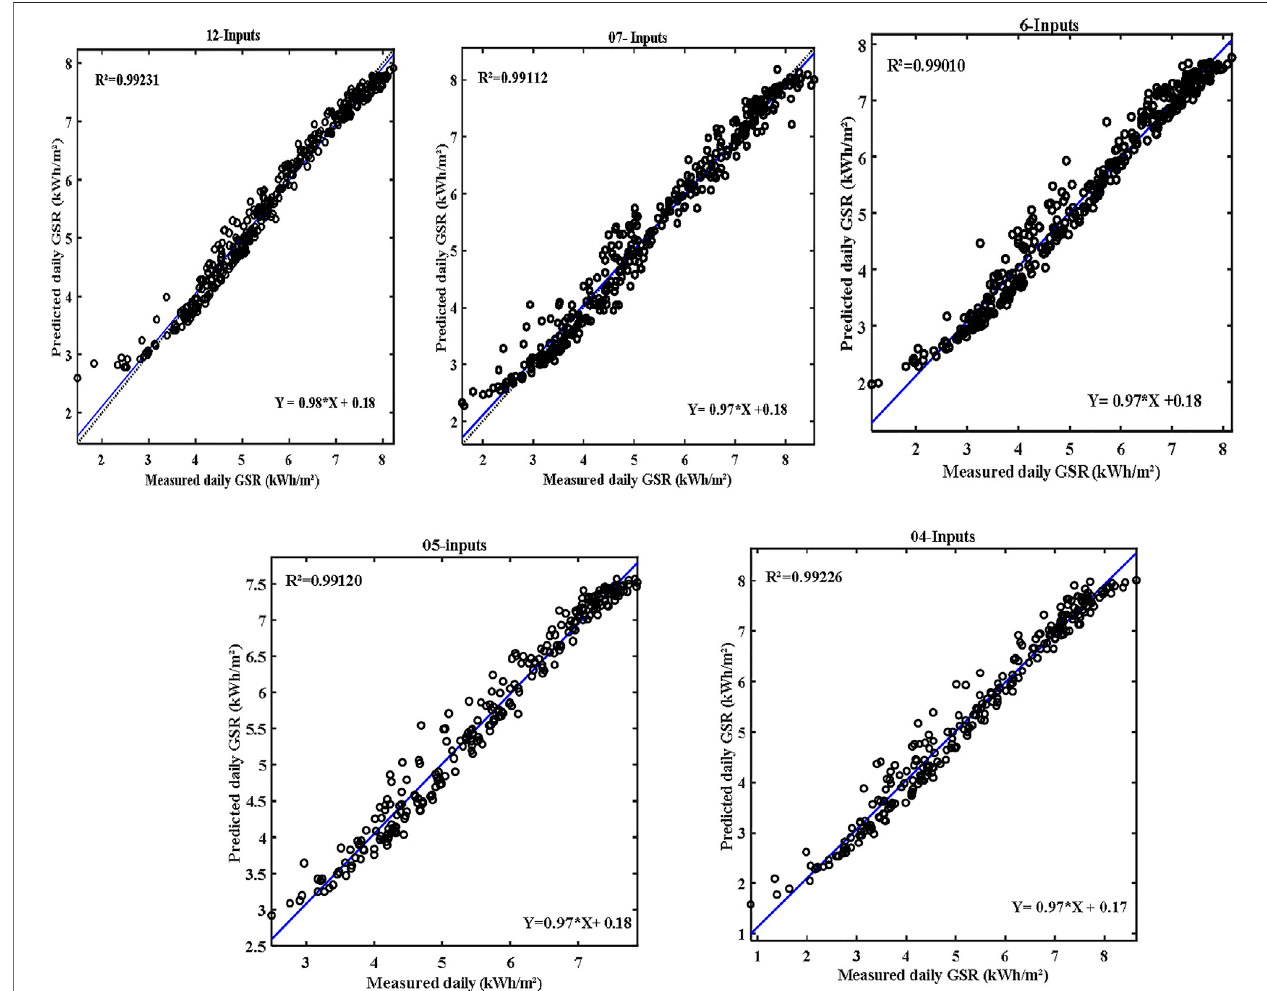
FIGURE 8 | Scatter plot of daily GSR predicted values by the best six inputs vs. measured values.